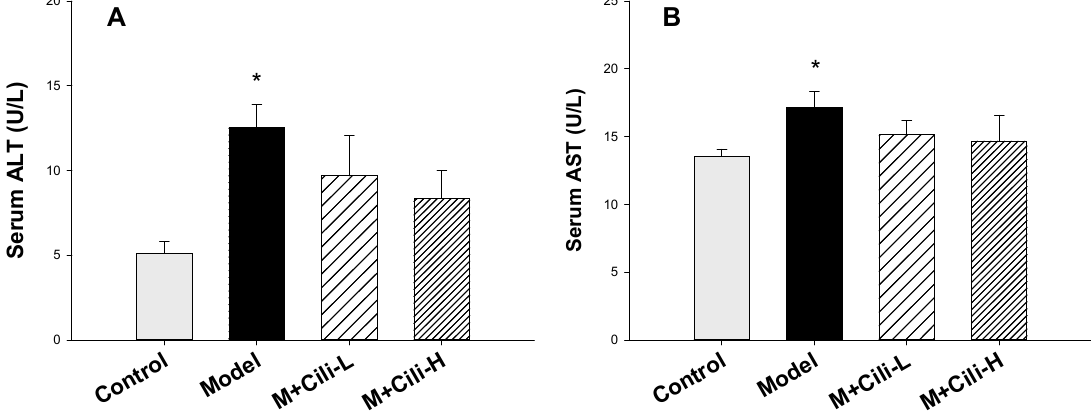
Figure 2. Serum alanine aminotransferase (ALT, ( A )) and aspartate aminotransferase (AST, ( B )) determination. Data are mean ± SEM ( n = 9–11), * Significantly different from the Control group, p < 0.05.